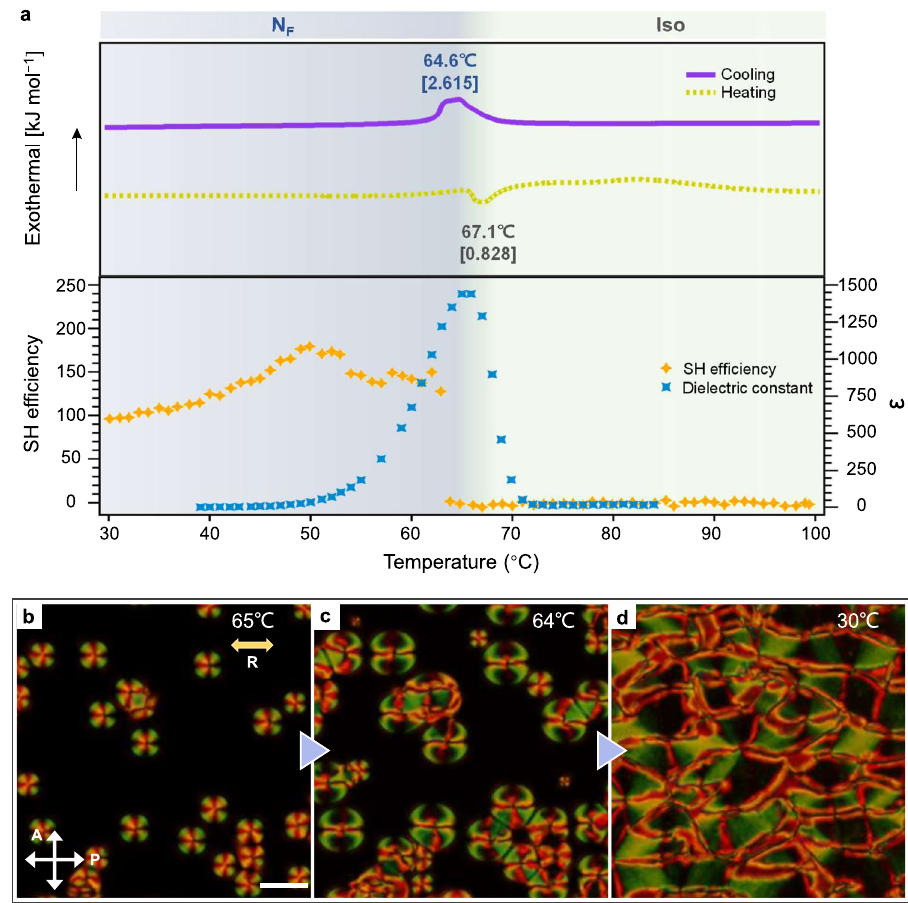
Fig. 2 | General properties of the ferroelectric nematic. a Top chart shows DSC curves of RM-OC 2 during cooling (violet solid line) and heating (yellow dash line) (rate: 3.0Kmin − 1 ). Enthalpies of the corresponding phase transitions are shown in the square brackets [kJmol − 1 ]. Bottom chart shows the temperature dependencies of the apparent dielectric constant at a frequency of 25Hz (blue squares) and SH